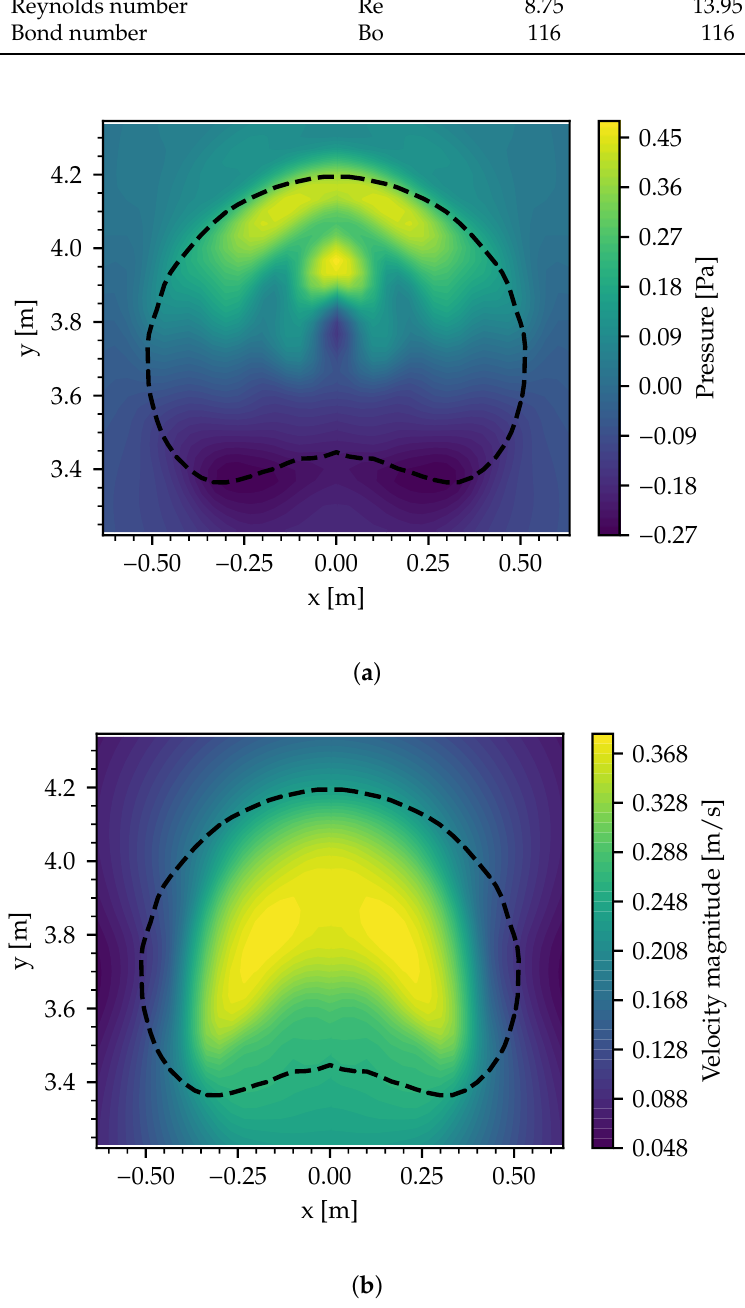
Figure 8. Mid-plane continuum results for the rising bubble in Case 1, showing ( a ) the pressure field and ( b ) the velocity field at t = 8.1 s.